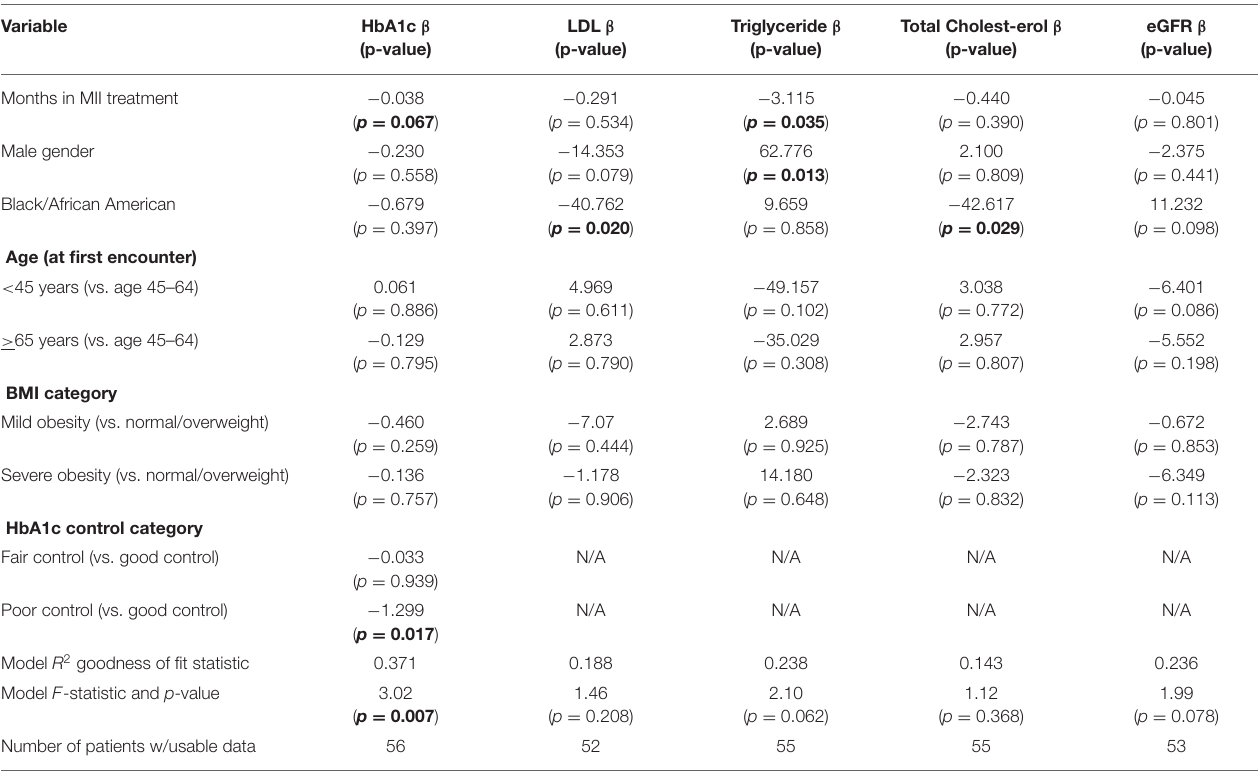
TABLE 2 | Regression models—lab data (changes in outcome measures).